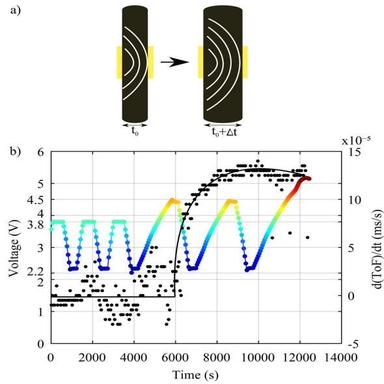
Time of flight (ToF) a) ToF diagram; b) d(ToF) vs voltage and time.